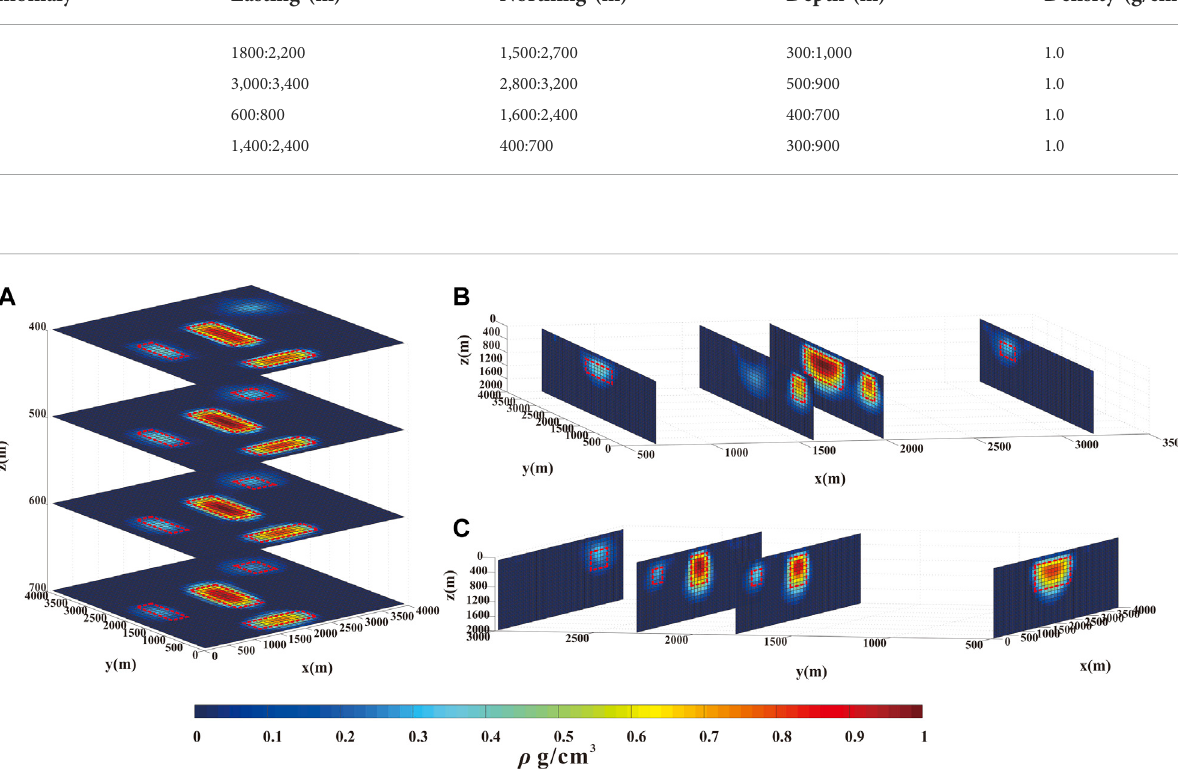
FIGURE 2 (A) the plan section of the recovered density model obtained by the inversion of the gravity anomaly at z = -400 m, -500 m, -600 m, and -700 m (B) X-directionsectionoftherecovereddensitymodelatx=700 m,1,600 m,2000mand3,200 m. (C) Y-directionsectionoftherecovered density model at y = 500 m, 1800 m, 2,300 m, and 3,000